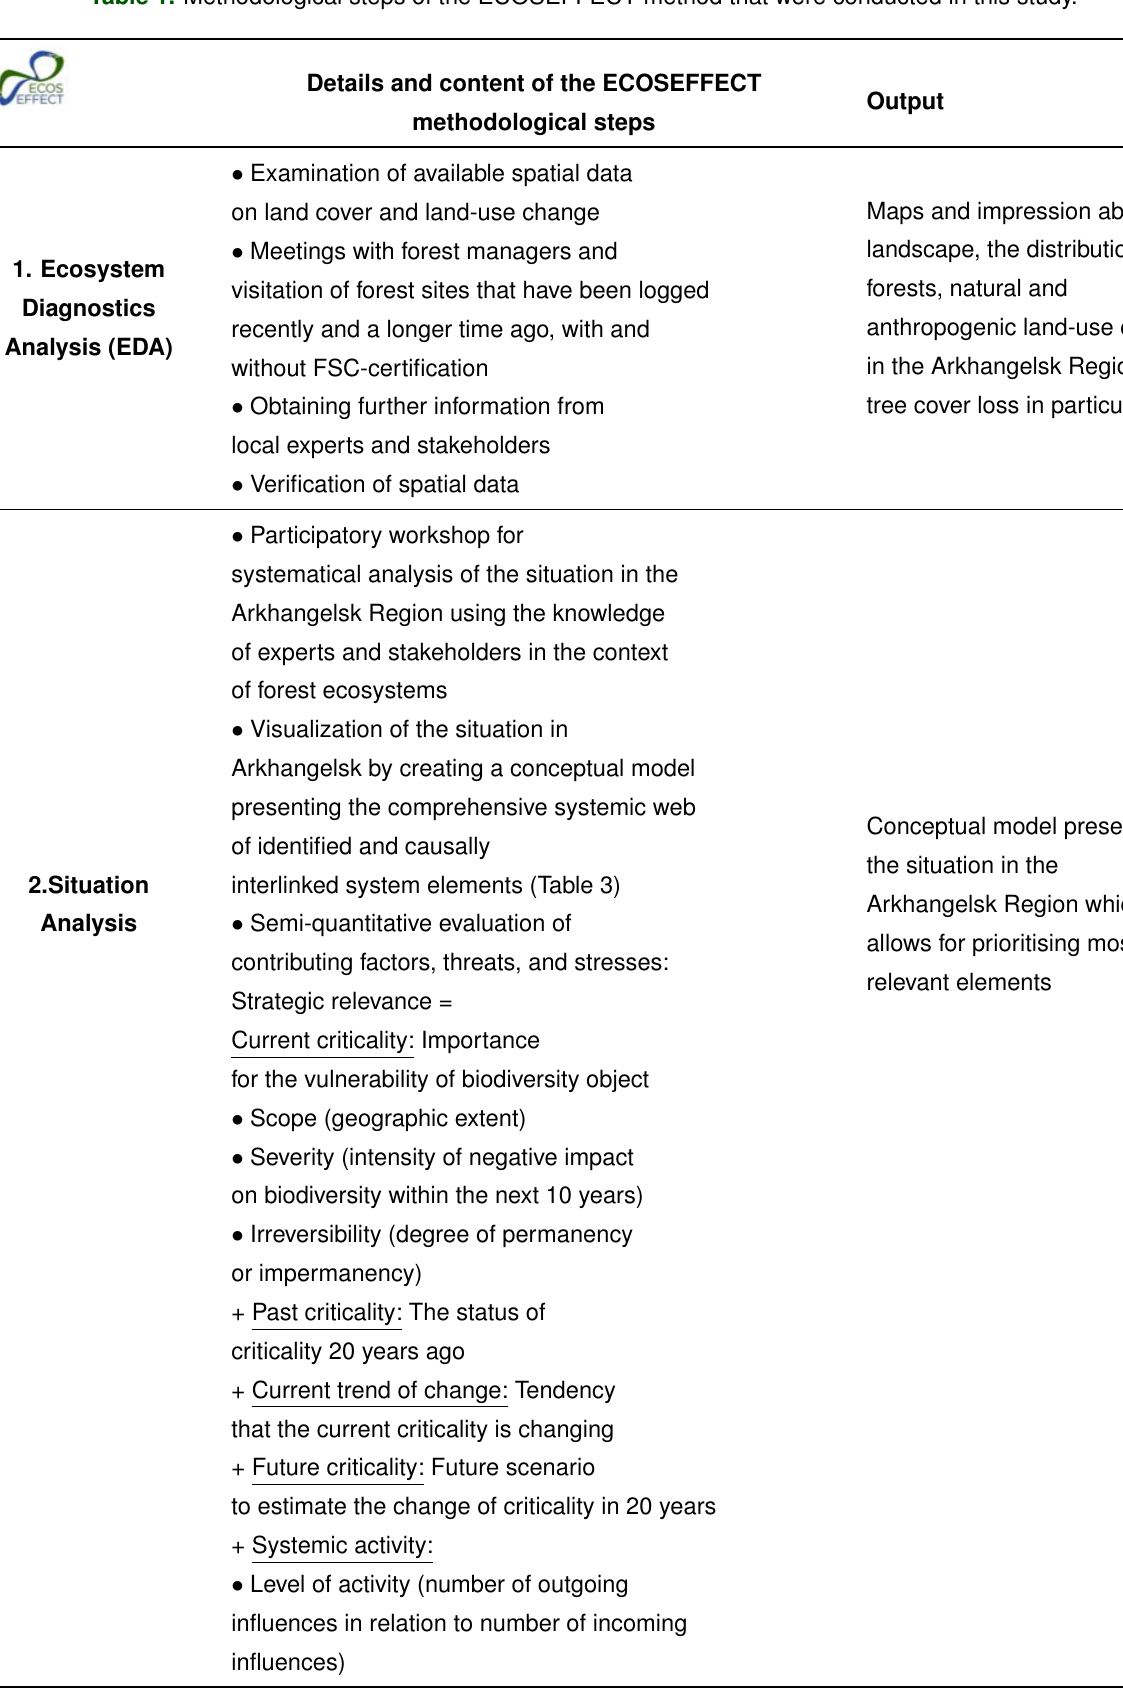
Table 1. Methodological steps of the ECOSEFFECT method that were conducted in this